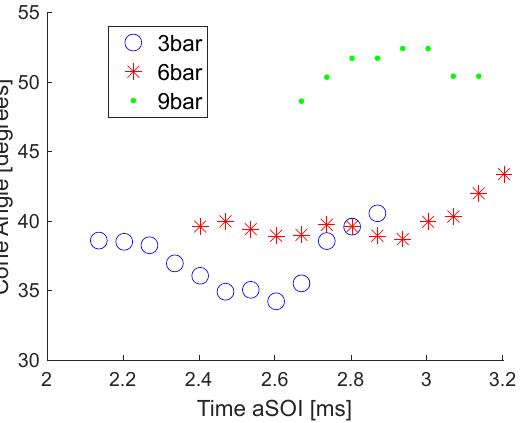
Figure 10. Cone angle as a function of time aSOI, at 3, 6 and 9 bar ambient pressure.